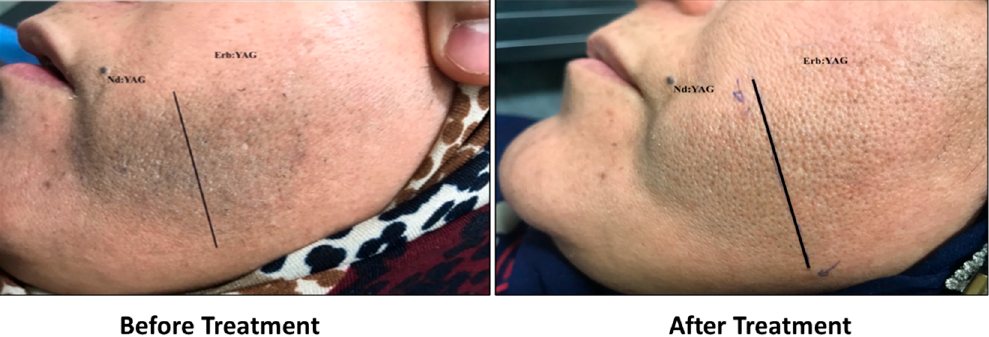
Figure 4. Forty-three-year-old female with facial Becker’s nevus before treatment and 2 weeks after the last treatment session with lesion area divided into two parts: one treated with fractional Erbium: YAG 2940 nm laser and the other part treated with Q-switched Nd: YAG 1064 nm laser.